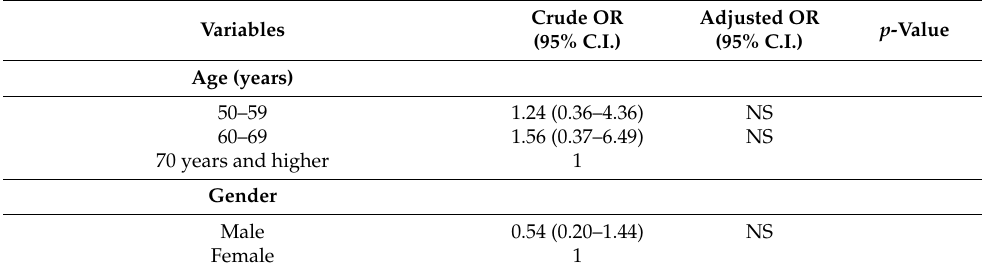
Table 5. Simple and multiple logistic regression analysis to determine factors associated with willingness to utilize palliative